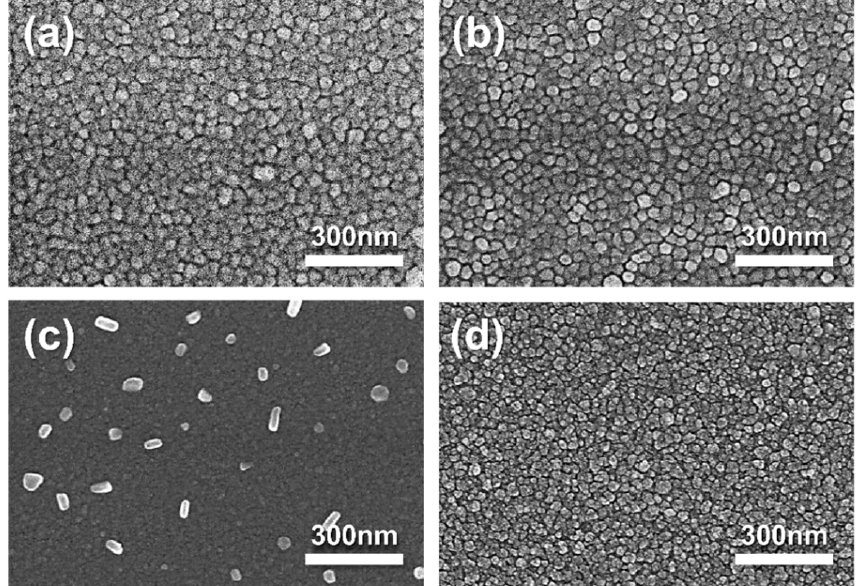
Figure 4. SEM micrographs of 100-nm-thick Ag-SDC cermet cathodes deposited under DC and RF powers of ( a ) Ag100-SDC50, ( b ) Ag60-SDC50, ( c ) Ag20-SDC50, and ( d ) Ag20-SDC80 on YSZ